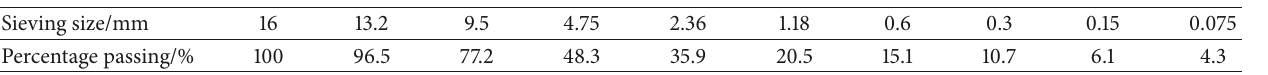
Table 1: Gradation of RAP.